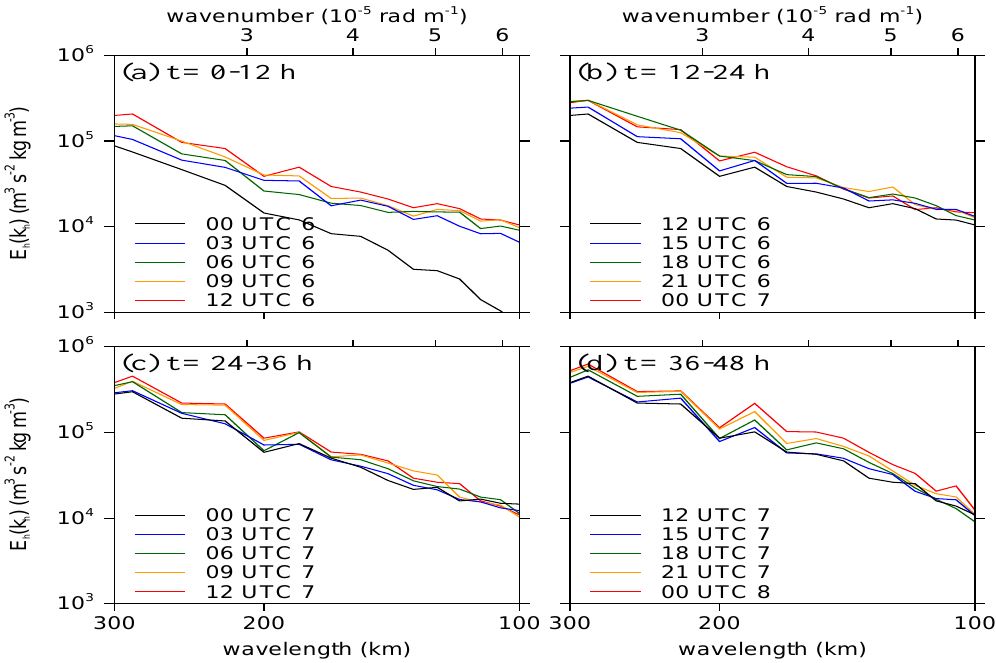
Figure 4. Time evolution of the HKE spectrum [ E h ( k h )] averaged vertically over the troposphere for ( a ) 0–12 h, ( b ) 12–24 h, ( c ) 24–36 h, and ( d ) 36–48 h, and zoomed in for 100 < λ h < 300 km (2 π / 3 × 10 − 5 < k h < 2 π × 10 − 5 rad m − 1 ). Spectra are plotted every 3 h. The reference lines correspond to the − 3 and − 5 / 3